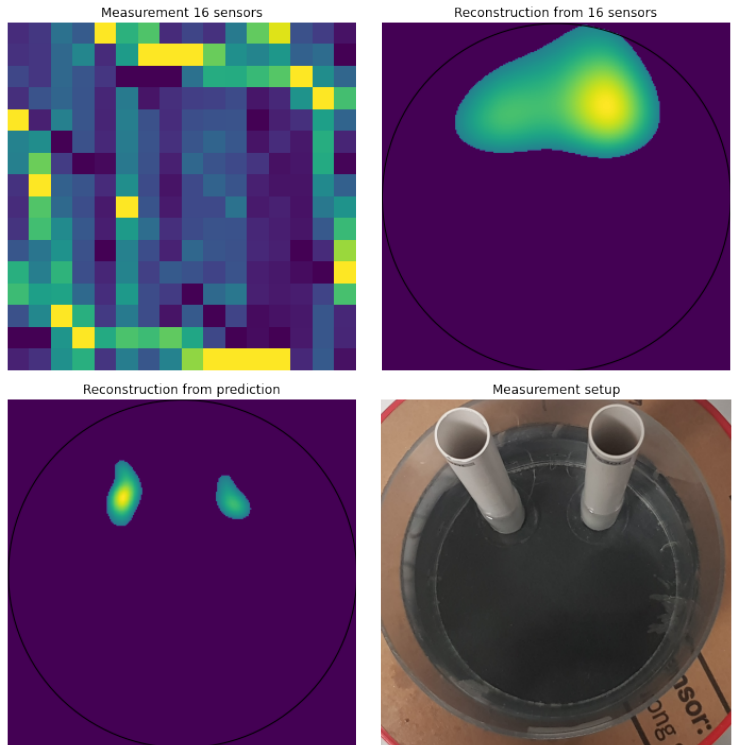
Figure 6. The results were obtained from real measurements with two phantoms located in the circular tank with two phantoms.